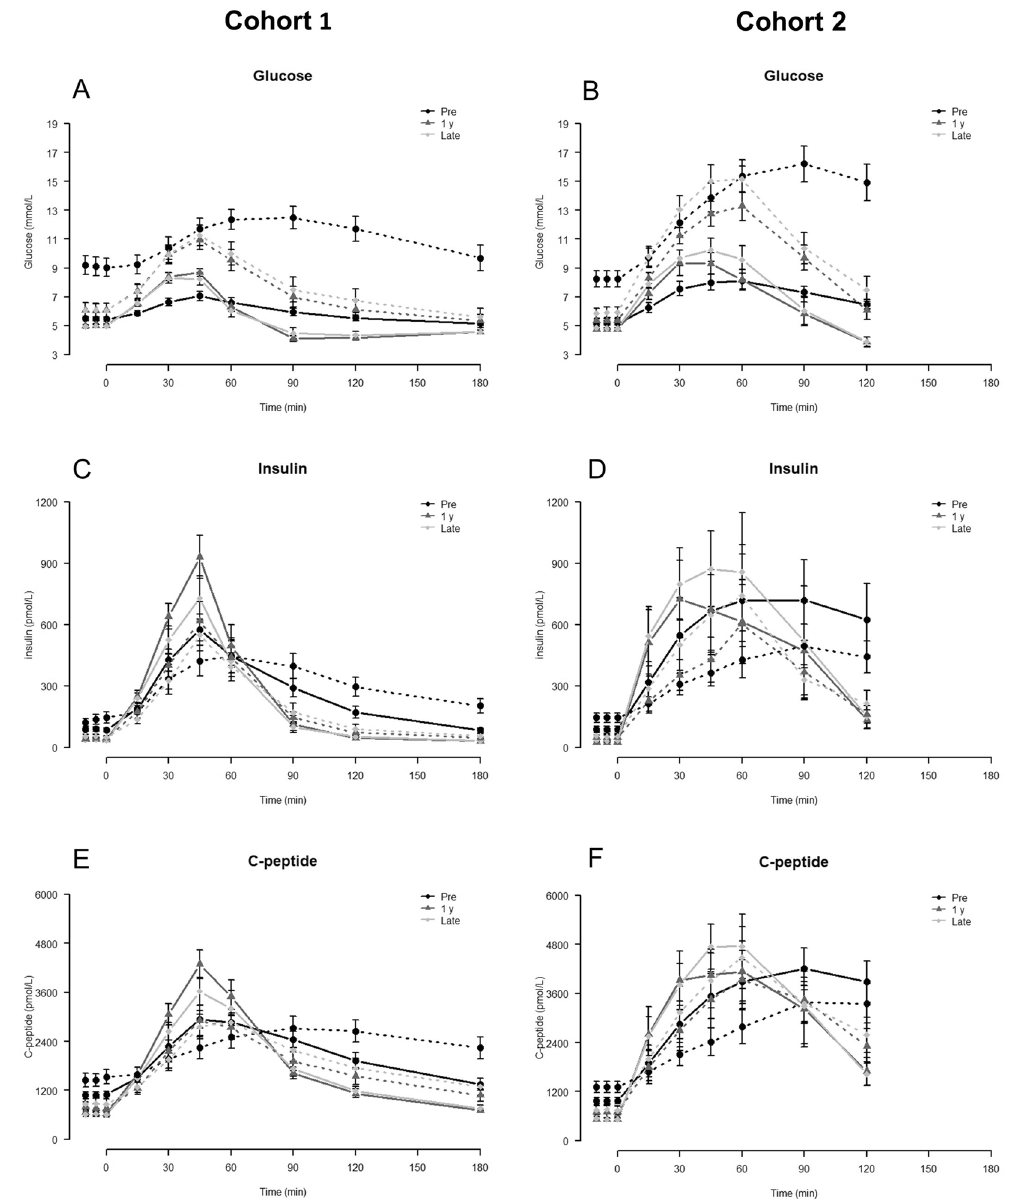
Figure 2. Glucose (A + B), Insulin (C + D) and C-peptide (E + F) concentrations in Cohort 1 (MMTT, A + C + E) and Cohort 2 (OGTT, B + D + F). Dotted lines are T2D, solid lines NGT. Data are mean ±